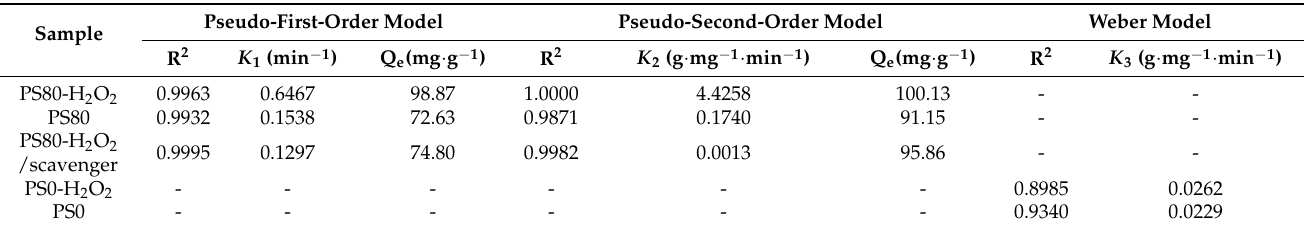
Table 2. Parameters from the kinetic modeling of Tetracycline on biochar.